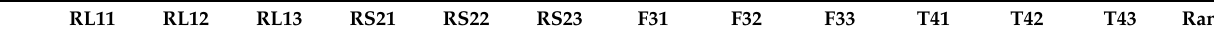
Table 9. Results of sensitivity analysis for scenario